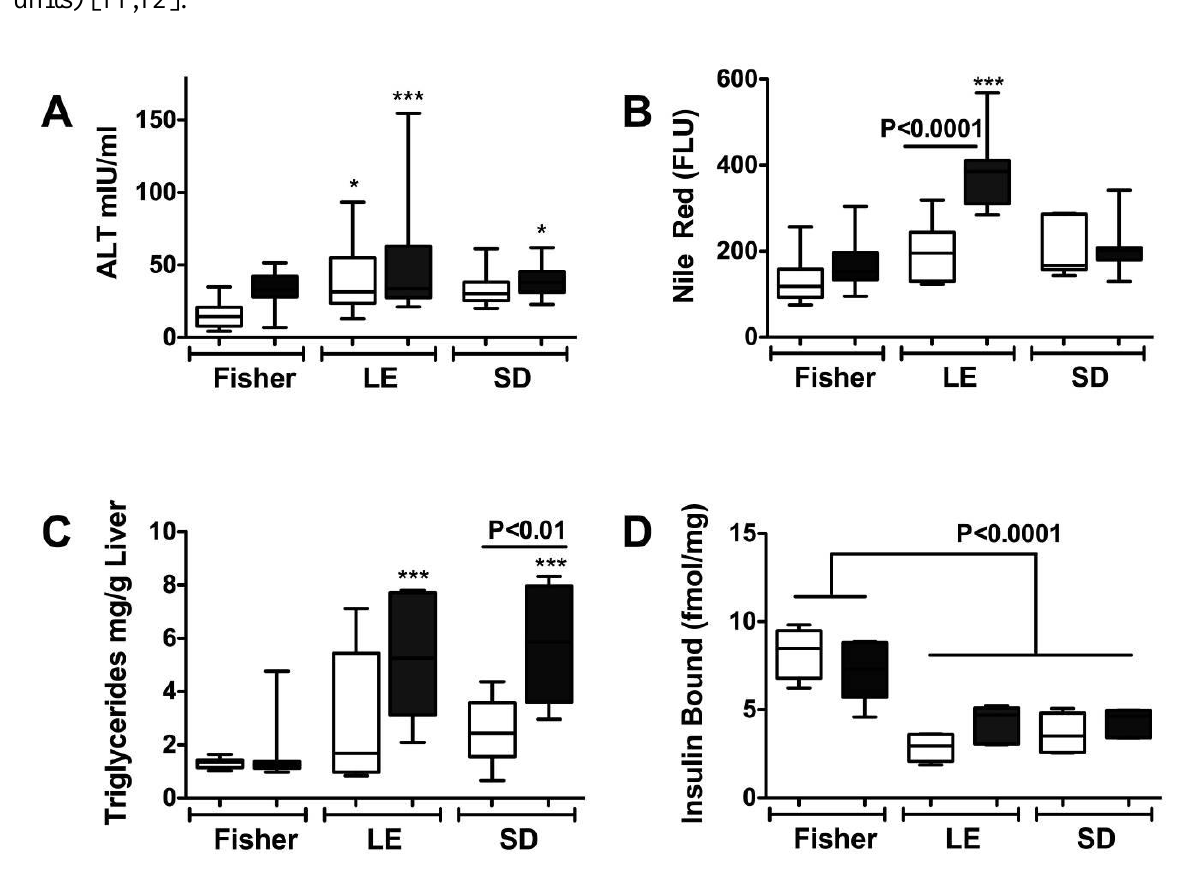
Figure 1. Genetic factors govern susceptibility to alcohol-induced liver injury, steatosis, and insulin resistance. Fisher 344 (Fisher), Long Evans (LE), and Sprague Dawley (SD) rats were fed with control or ethanol containing liquid diets for eight weeks, and then (A) serum was obtained to measure to measure alanine aminotransferase (ALT), and livers were harvested to assess (B) lipid content using the Nile Red assay, (C) triglycerides, and (D) insulin receptor binding. (* P < 0.05; *** P < 0.001; FLU = fluorescent light units)